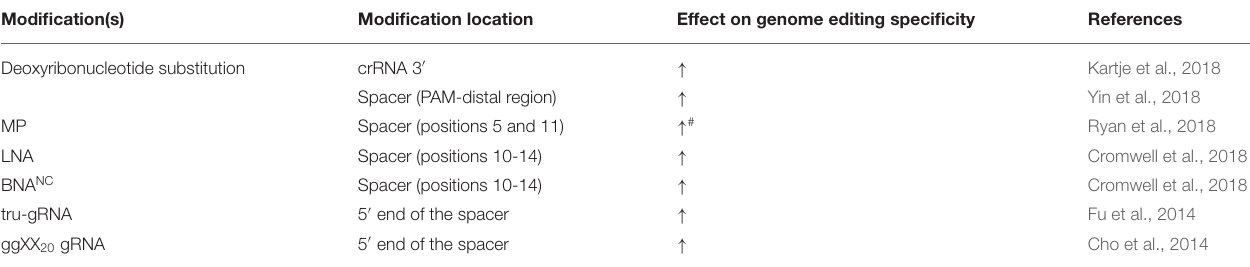
TABLE 2 | gRNA modifications to improve CRISPR-Cas9 specificity in cultured mammalian